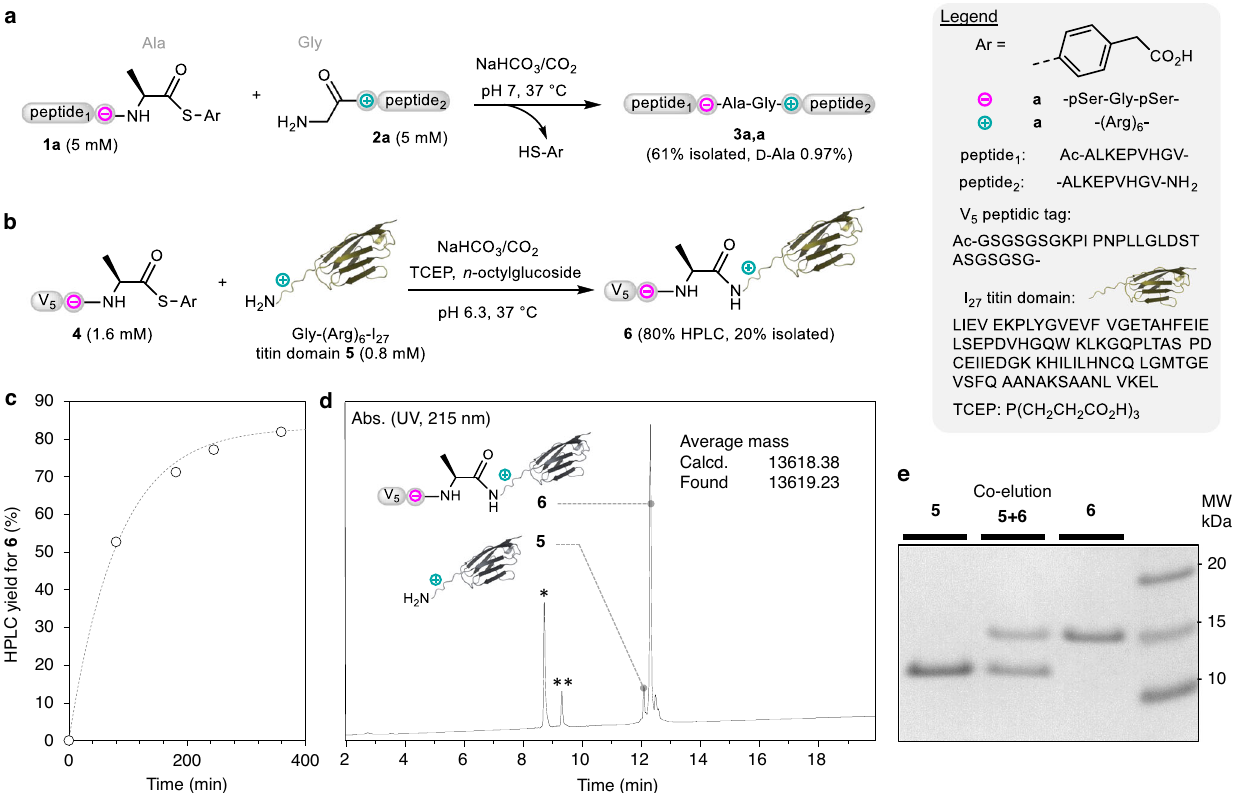
Fig.2|Electrostaticassistanceofpeptidethioesteraminolysis.a Thereactionof peptide thioester 1a (5mM) with glycyl peptide 2a (5mM) shows the formation of targetpeptide 3a,a asthemajorproduct.Thereactionwasruninsodiumhydrogen carbonate/carbondioxidepH7bufferat37°C,whichwasobtainedbyequilibrating sodium hydrogen carbonate (50mM) in a cell incubator (5% partial CO 2 pressure). b The reaction of peptide thioester 4 (1.6mM) with Gly-(Arg) 6 -I 27 titin protein 5 (0.8mM) yielded target protein 6 as the major product. Conditions: